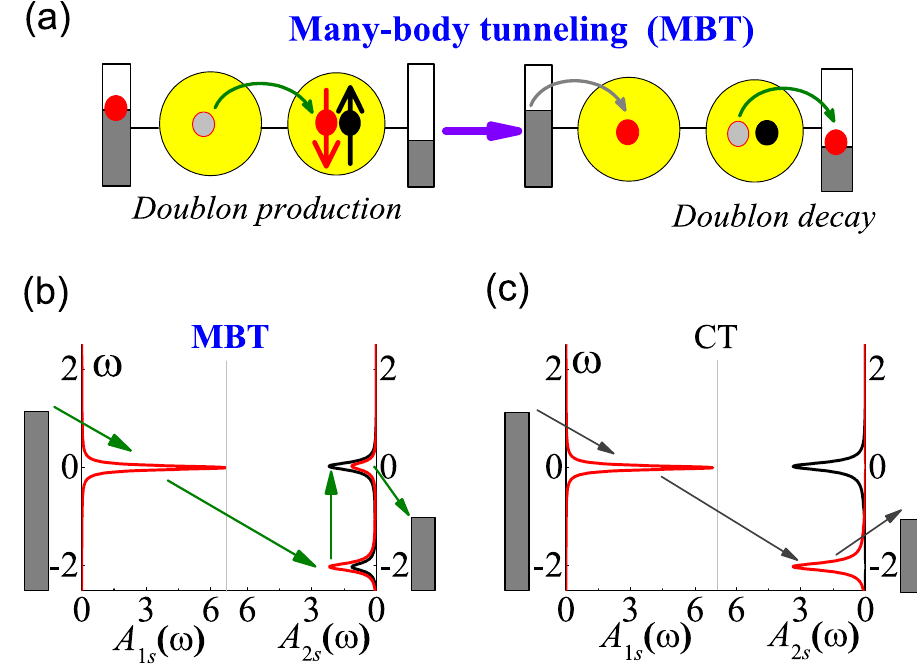
Figure 1. ( a ) Schematic diagram of the many–body tunneling (MBT) in DQDs. ( b ) and ( c ) show calculated nonequilibrium spectral functions A 1 s ( ω ) and A 2 s ( ω ) with = ↓ s (red) and s = ↑ (black), and illustrated processes of the MBT and CT respectively. The accurate HEOM is performed in ( b ) and the HEOM truncated at tier level L = 1 in ( c ) at t = 0.01 meV, and eV = U = 2.0 meV. = = − . ↓ ↑ 2 0   meV. Due to the lifted spin degeneracy of 2 2 QD1, A 1 ↓ ( ↑ ) peaks at = ↓ 0  meV ( = . ↑ 3 0  meV (not shown)). The dot-reservoir coupling strength and 1 1 temperature are Γ = 0.1 meV and T = 0.1 meV,